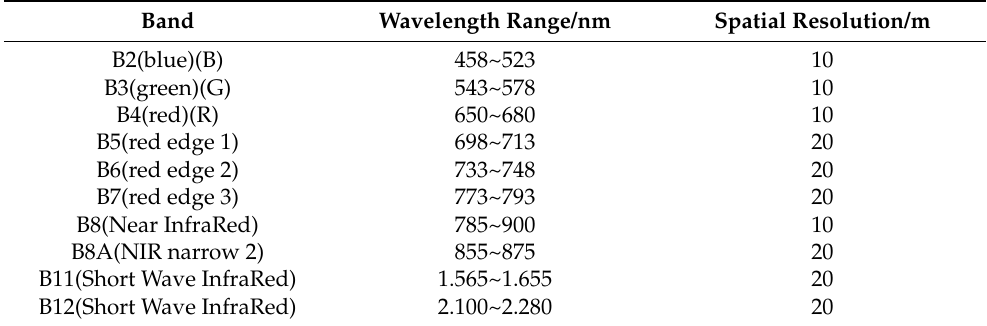
Table 3. Band information of Sentinel 2 image. Additionally, it excludes Band 1 and Band 9, which are not involved in the study.